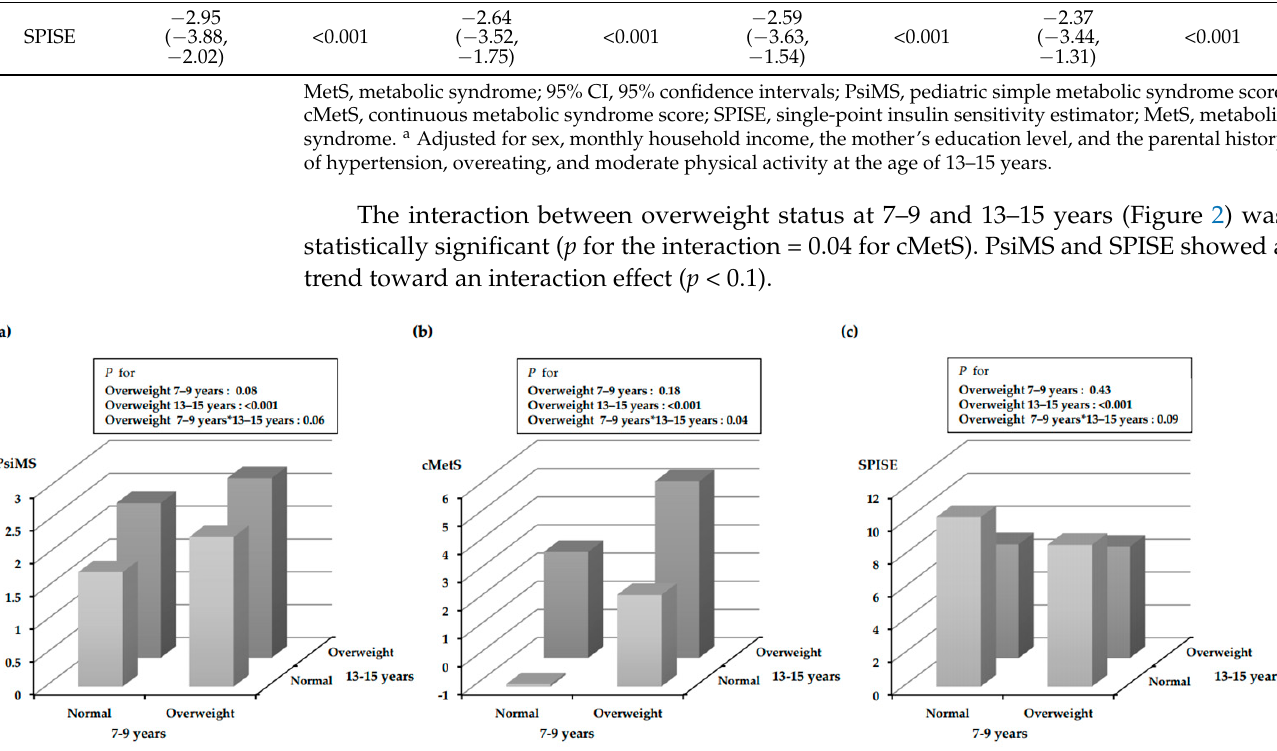
Figure 2. The interaction effect of overweight groups at two time points (at ages 7–9 and 13–15 years) on the metabolic syndrome index in adolescence. Adjusted for sex, household income, mother’s education level, parental history of hypertension, overeating, and moderate physical activity. BMI, body mass index; PsiMS, pediatric simple metabolic syndrome score; cMetS, continuous metabolic syndrome score; SPISE, single-point insulin sensitivity estimator. ( a ) The interaction between the 7–9 years BMI group and the 13–15 years BMI group on PsiMS; ( b ) The interaction between the 7–9 years BMI group and the 13–15 years BMI group on cMetS; ( c ) The interaction between the 7–9 years BMI group and the 13–15 years BMI group on SPISE.